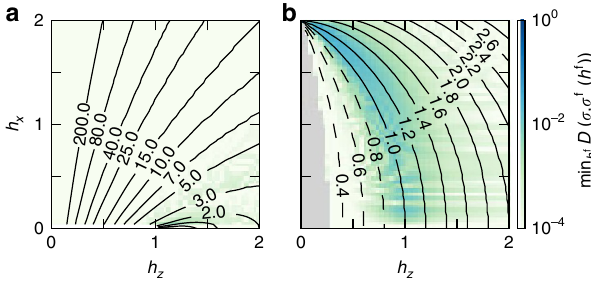
Figure 3 | Mapping the optimal free model to a transverse-field Ising model. ( a ) The FM model and ( b ) the AFM model both at system size L ¼ 16. Contours indicate the transverse-field h f , dashed lines for those in z the symmetry broken phase and solid otherwise (including the critical value 1). The background colour plot gives the distance min h f D ( s , s f ) h f z ¼ z (log scale) signifying the success of the mapping. In this way the interacting system is given a description in terms of a free-fermion model. The region near the h z ¼ 0 classical axis of the AFM is removed (grey region) because our calculations do not resolve all symmetries of the